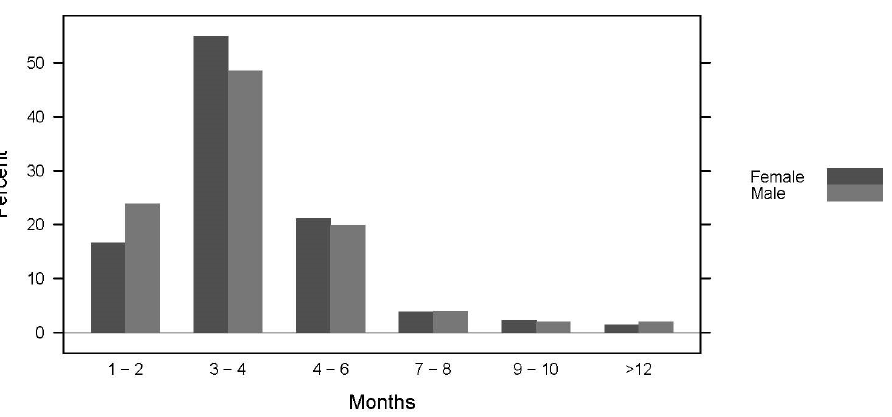
Figure 2. Sex-based differences in the prevalence of training duration (displayed in six categories) for main events. Data are presented by percentage.